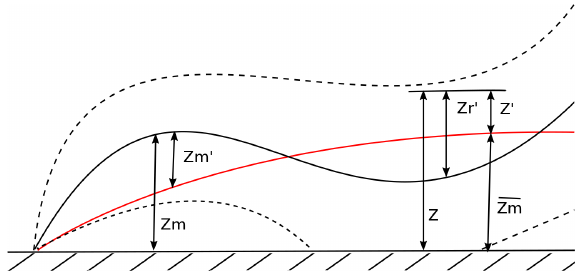
Figure 4. Scheme of an idealized plume dispersing from a ground point-source. Shown here are the mean position of the instantaneous plume z m and the centerline position as well as the total mean of centerline positions z m (red line). Also shown are the displacements of particles in the instantaneous plume from its centerline position z (cid:48) r and from the total mean centerline position z (cid:48) as well as the dis- placement of the instantaneous centerline from the total mean cen- terline z (cid:48) m .